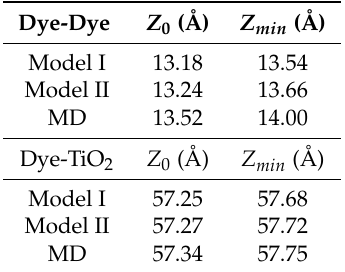
Figure 8. Energy gradient between ( a ) two dye molecules and ( b ) dye molecule interacting with TiO 2 molecule obtained from continuum Models I and II, and from MD simulation. Table 2. Values of Z 0 and Z min for continuum and discrete